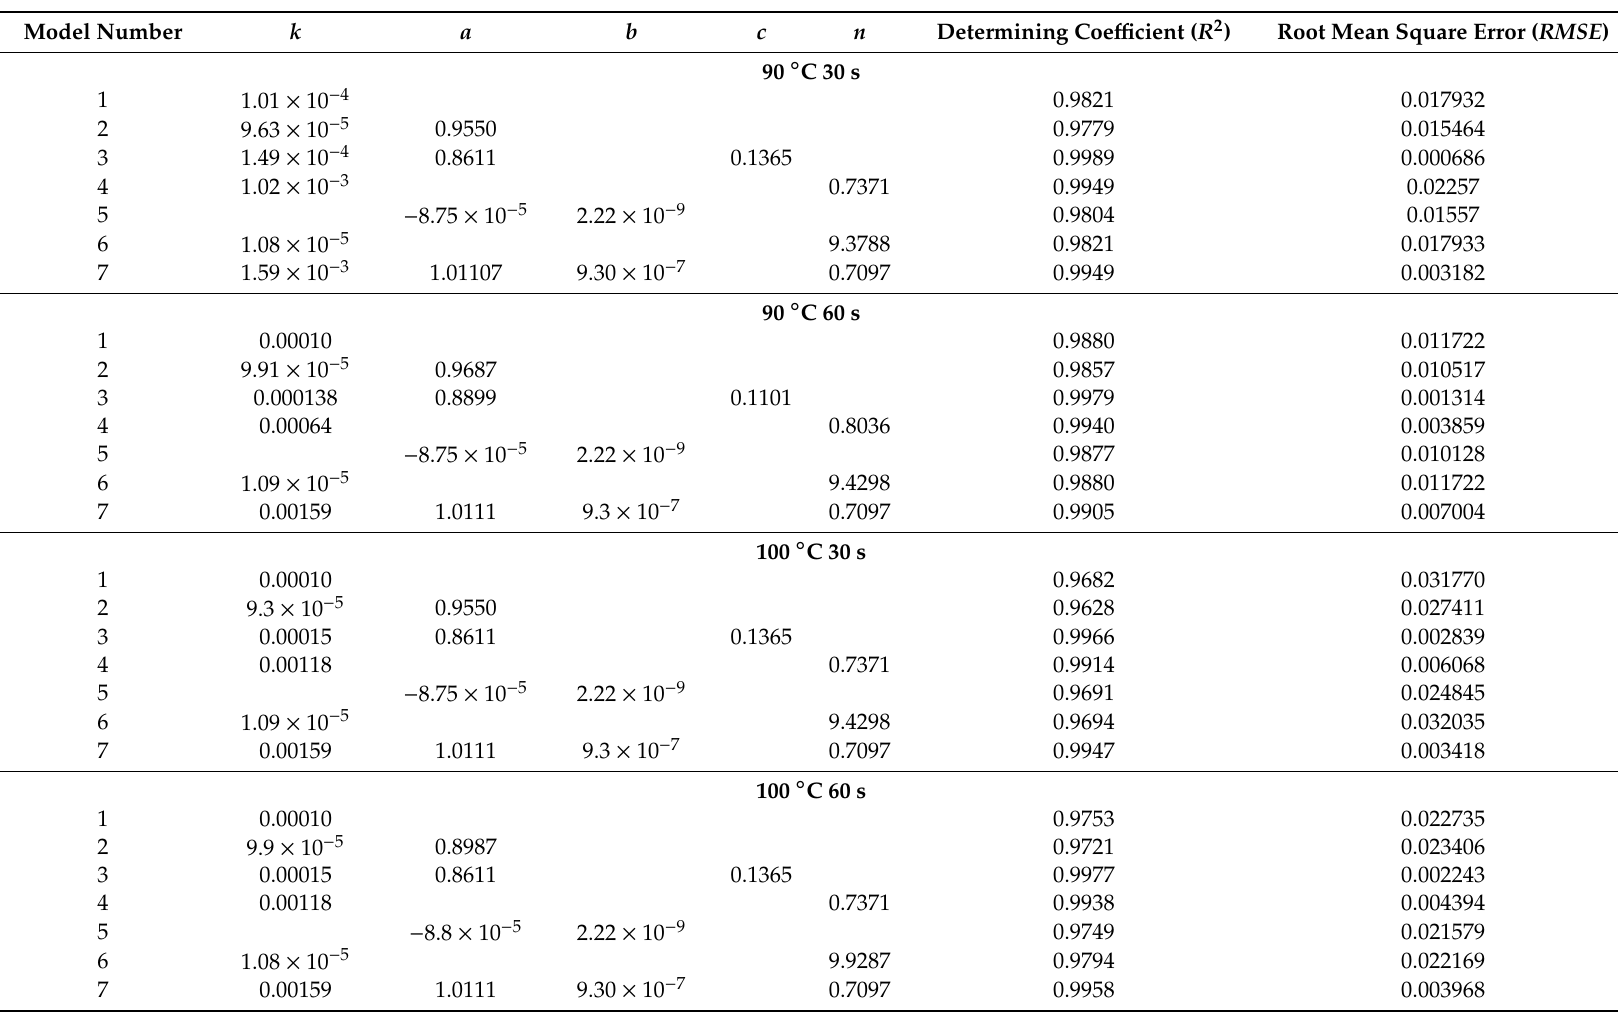
Table 3. Curve fitting criteria for various mathematical models and parameters for blanched and unblanched pomegranate arils cv. Acco. Model